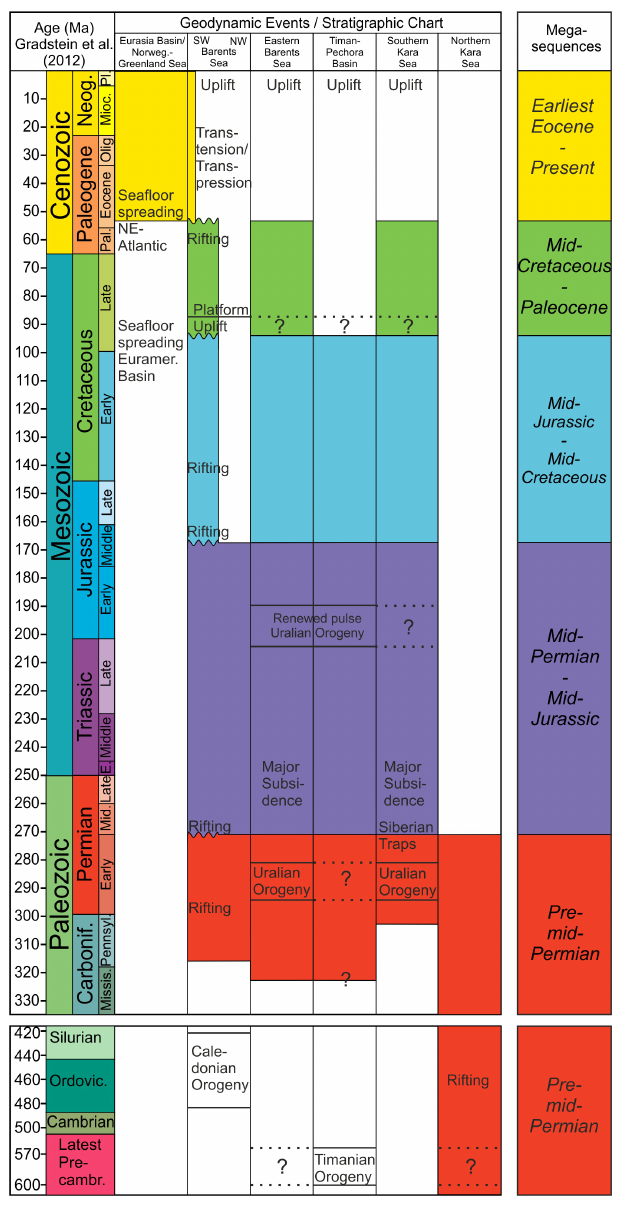
Figure 2. Stratigraphic megasequences resolved in the 3-D struc- tural model in relation to regional tectonic